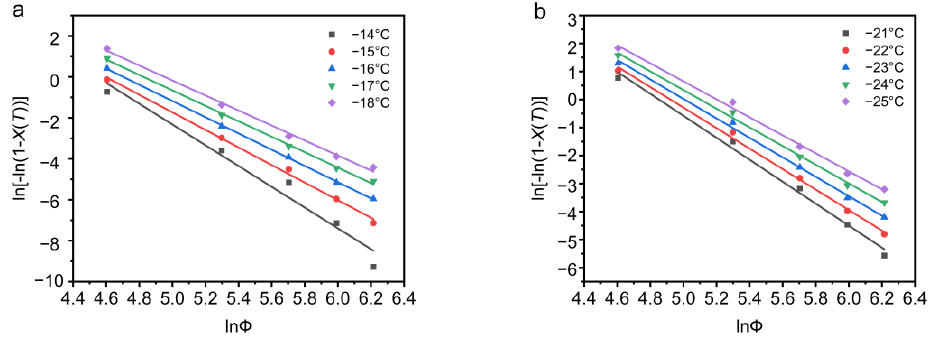
Figure 4. ( a ) PEG and ( b ) PEG-PCL non-isothermal crystallization process ln[−ln(1 − X ( T ))] plots lnΦ.